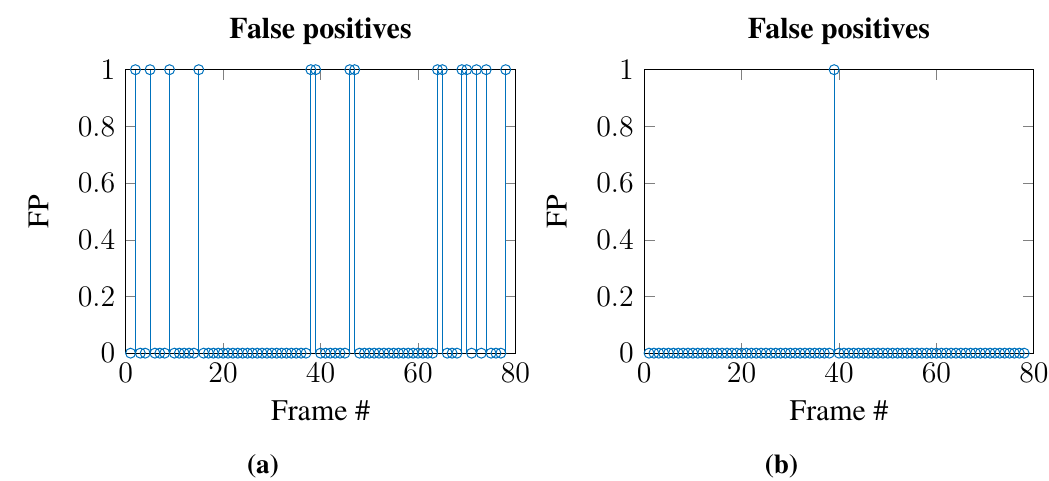
Figure 9. Reduction of false positives due to tracking. Here, three consecutive frames are evaluated. ( a ) False positives before tracking; ( b ) false positives after